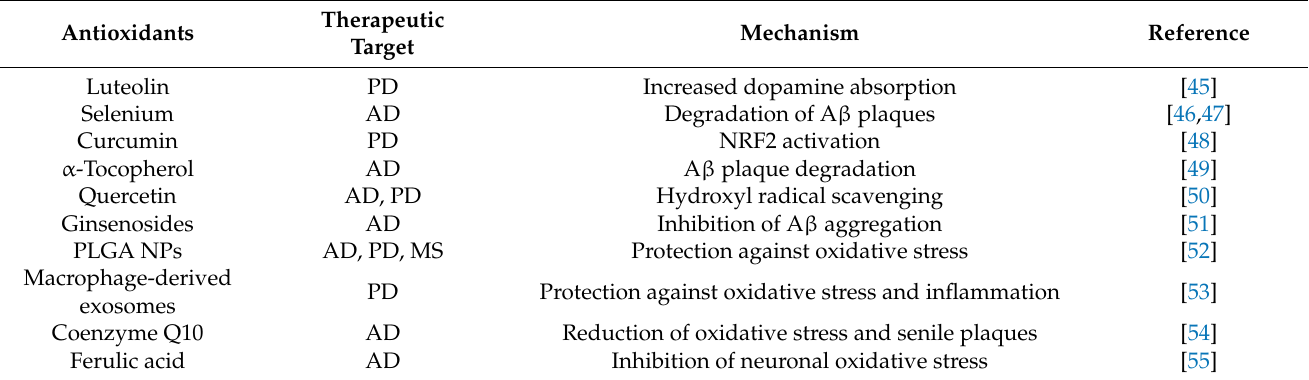
Table 1. Antioxidants with therapeutic effects on neurodegenerative diseases.